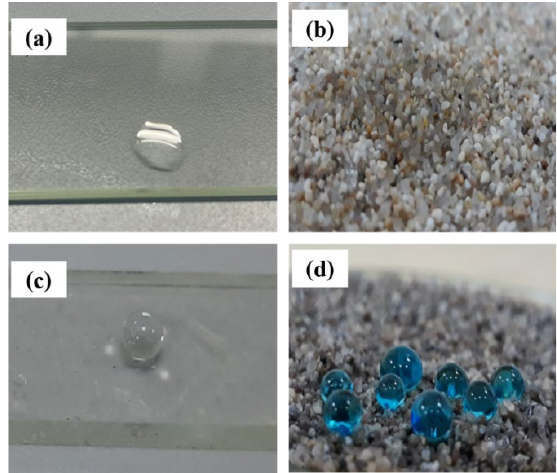
Figure 7. Optical images of the wetting states of water droplets on the glass before ( a ) and after treatment ( c ) and sand before ( b ) and after treatment ( d ).